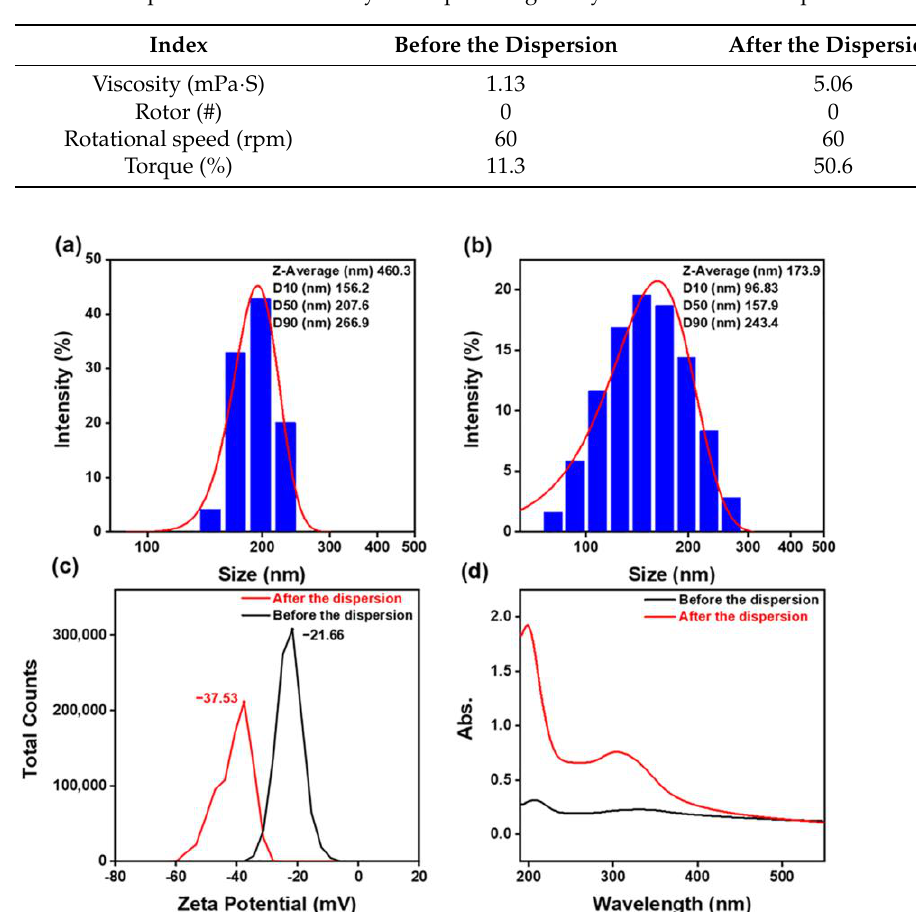
Table 2. Comparison of the viscosity of the polishing slurry before and after dispersion.